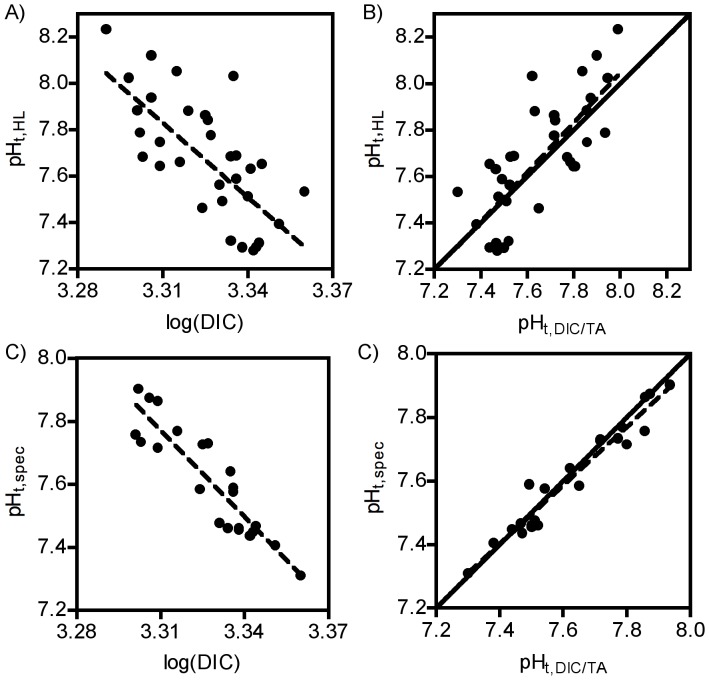
Relationships between pH measurements and DIC-derived measurements.Top row: relationships with pH measured with in-situ probe at time of water collection, Bottom row: relationships with pH of concurrently collected water samples measured spectrophotometrically. Left column: relationship of DIC concentration to pH measures, Right column: relationship to pH calculated from DIC and TA measurements using CO2SYS program. Solid lines: identity relationship, dashed lines: lines of best fit from linear regression.